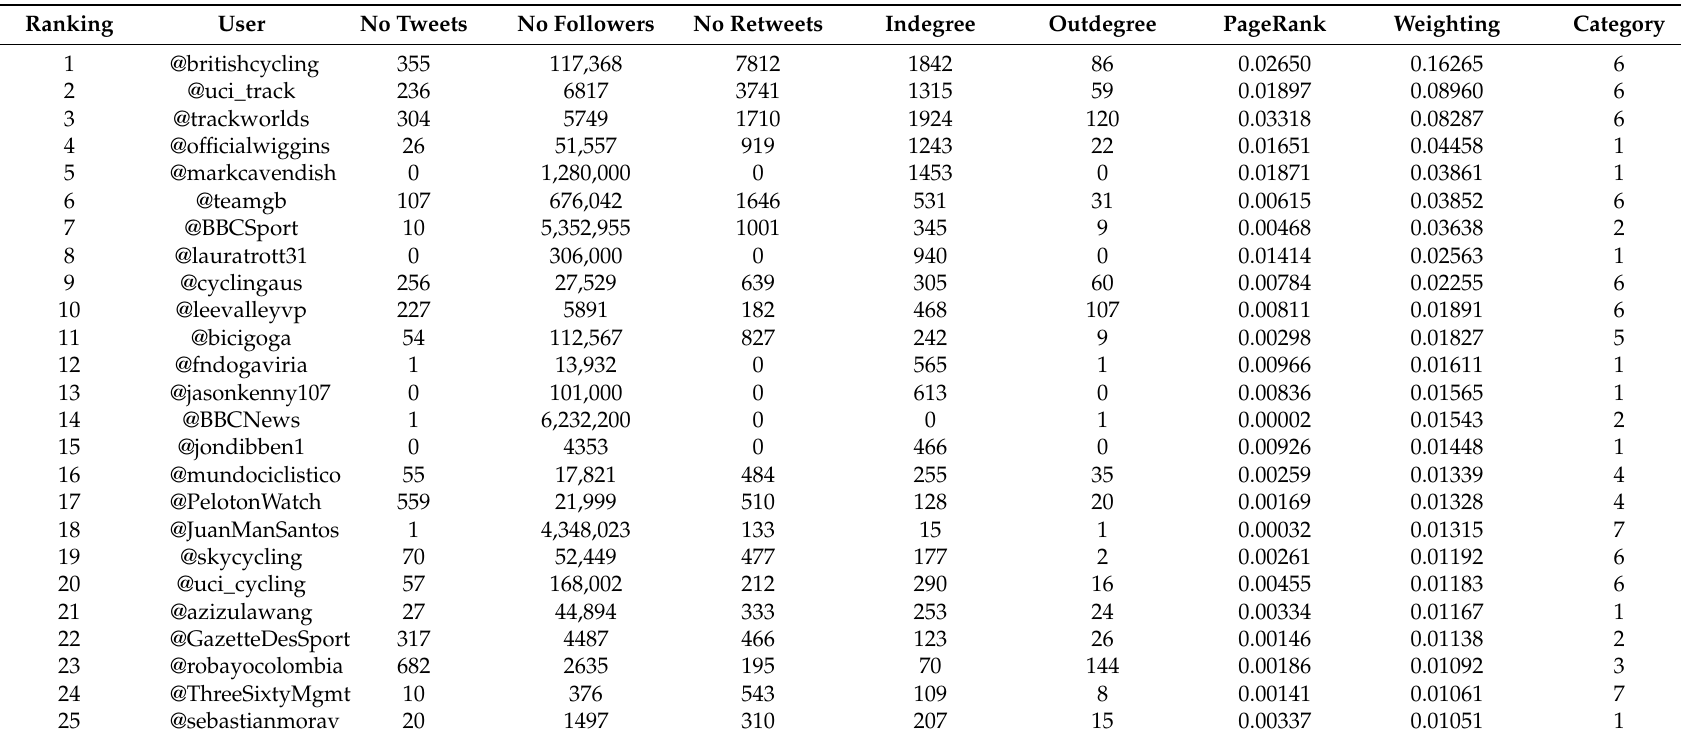
Table 6. The 25 most influential accounts with a breakdown by variable and group allocation. World Championship